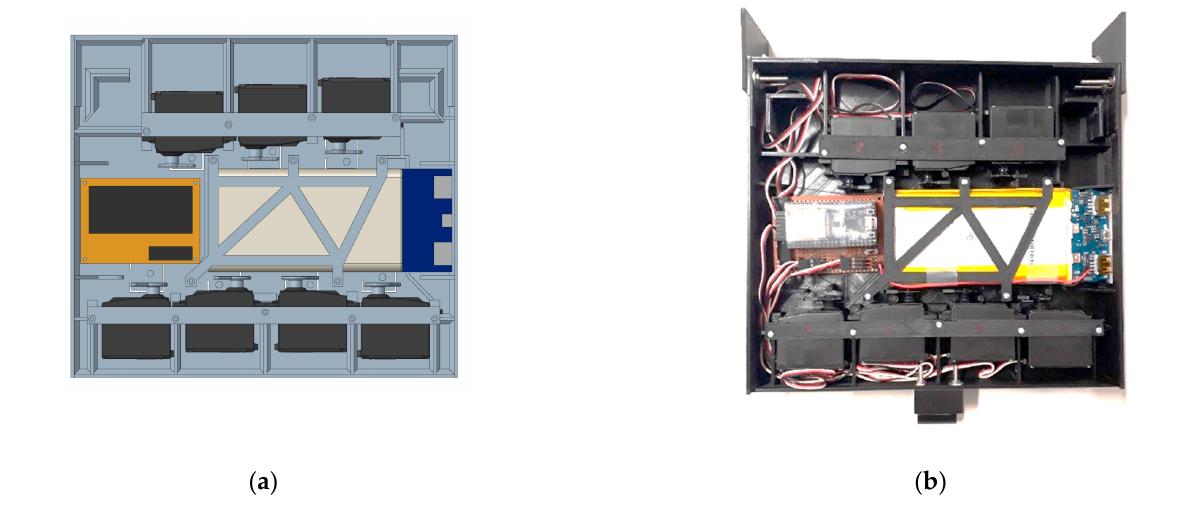
Figure 5. Back view of the IoT device: ( a ) CAD representation; ( b ) real implementation.